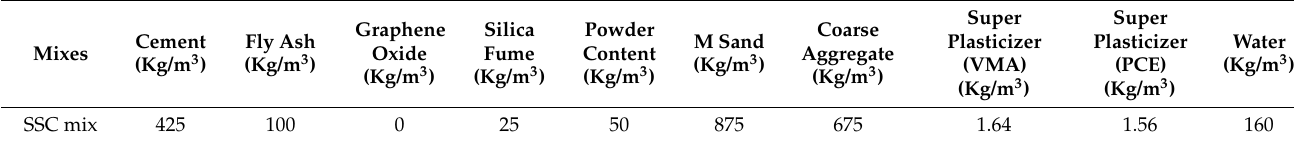
Table 3. Finalized mix design for Fly ash=based self-compacting concrete (FSCC).